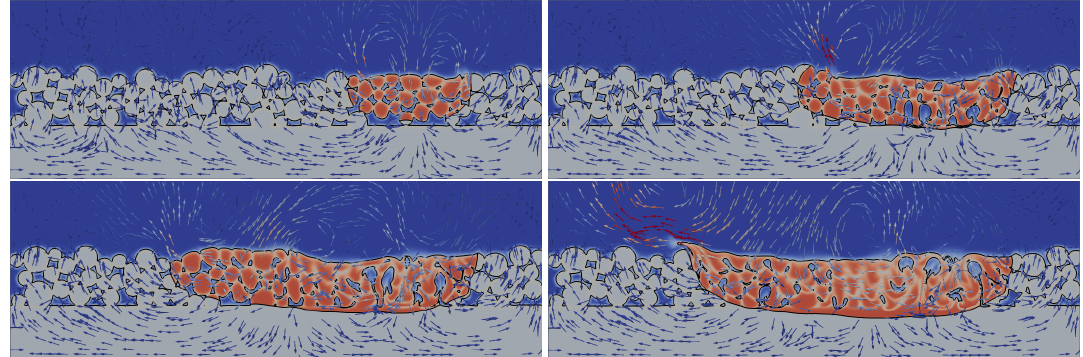
Figure 2. Powder bed fusion, according to a diffuse-interface melt pool model, with superimposed flow velocity vectors. Gas shown in blue, solid metal in gray, and liquid metal in